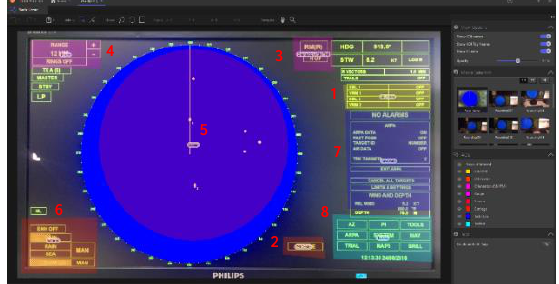
Figure 3. Areas of interest on the radar